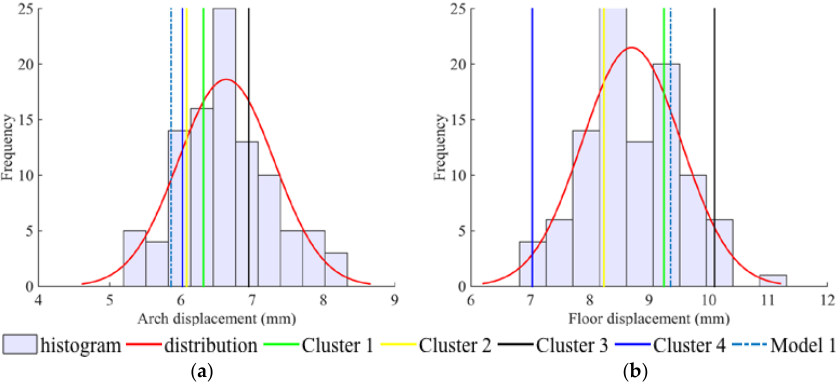
Figure 13. Histograms and distribution fitting curve for the 100 realisations and values (lines) for models 1 to 5 of displacements in: ( a ) the centre of the tunnel arch; ( b ) the centre of the tunnel invert.